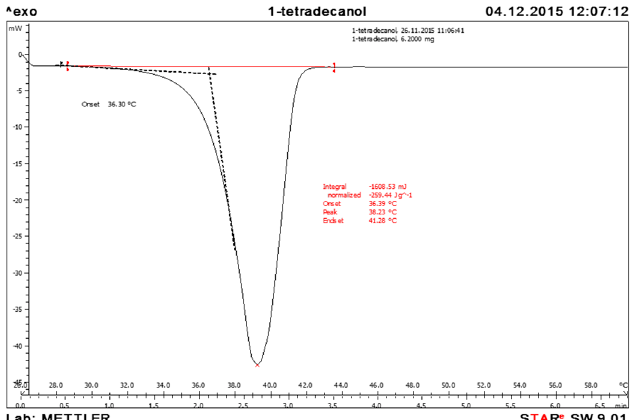
Figure A3. I-tetradecanol DSC test curve.